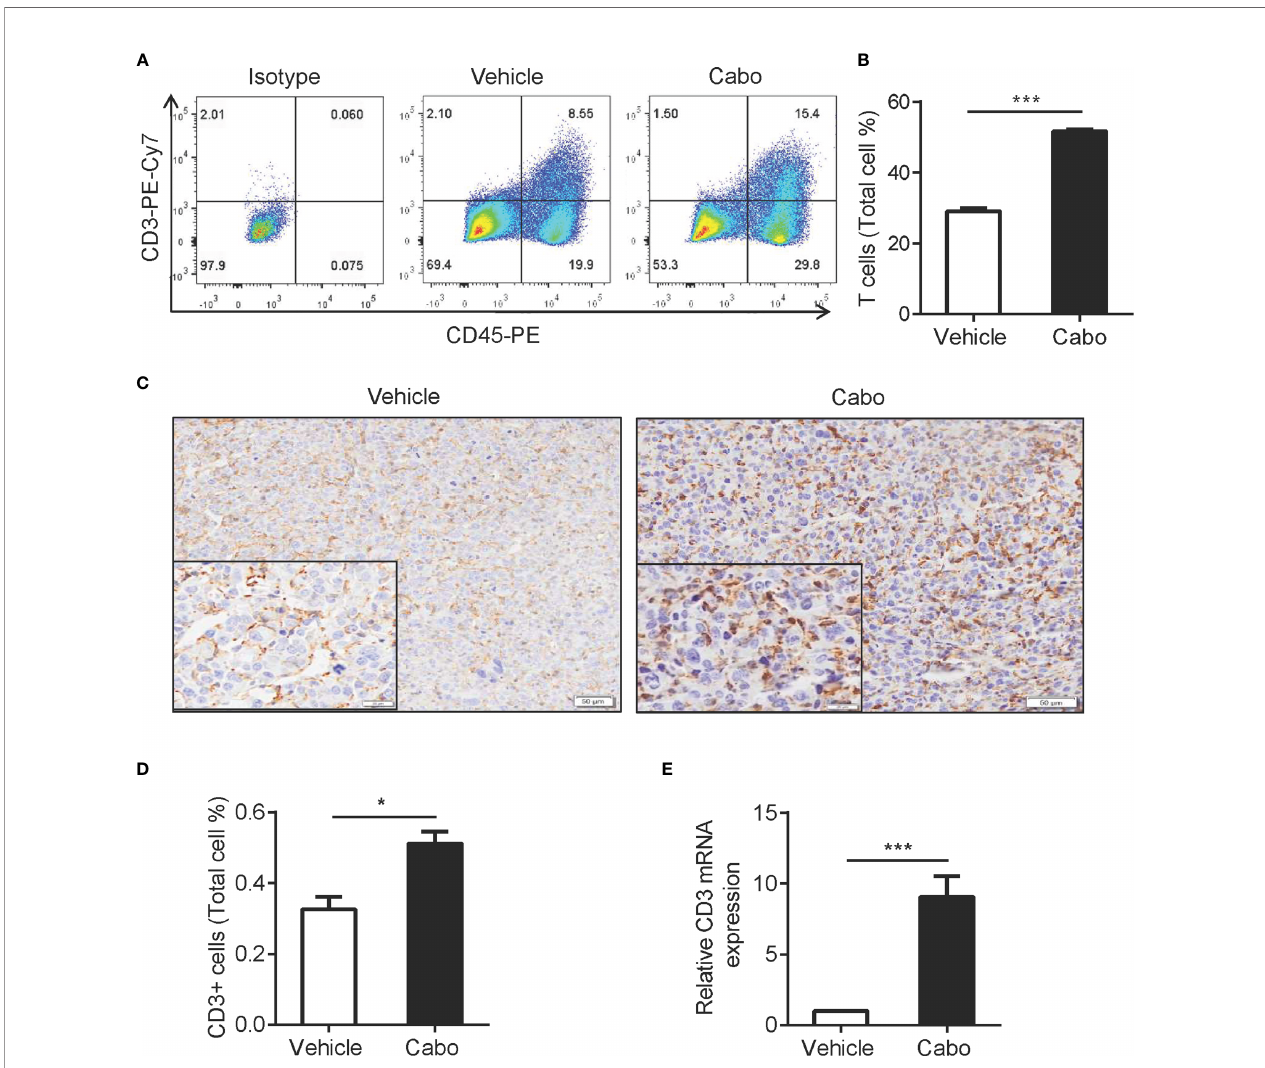
FIGURE 5 | Cabozantinib treatment increases T cell in fi ltration into tumors. Mice were treated as in Figure 2A . (A, B) Representative FACS plot and quantitative results show the frequencies of T cells in tumors from vehicle- or cabozantinib-treated mice. (C, D) Representative IHC staining for CD3 (C) and quantitative results (D) of tumor in fi ltrating T cells in vehicle- or cabozantinib-treated mice. CD3 positive rates (D) were analyzed using Image-Pro Plus software based on 3 representative visual areas in each section from each tumor (n=6 per group). A-D experiments were repeated three times. (E) Mouse CD3 mRNA expression detected by quantitative RT-PCR. RNA was extracted from tumor tissue from mice that received vehicle or cabozantinib treatment. Expression levels are normalized to vehicle (n=3 for biological replicate). * P <0.05, *** P <0.001 by unpaired t-test. This experiment was repeated two